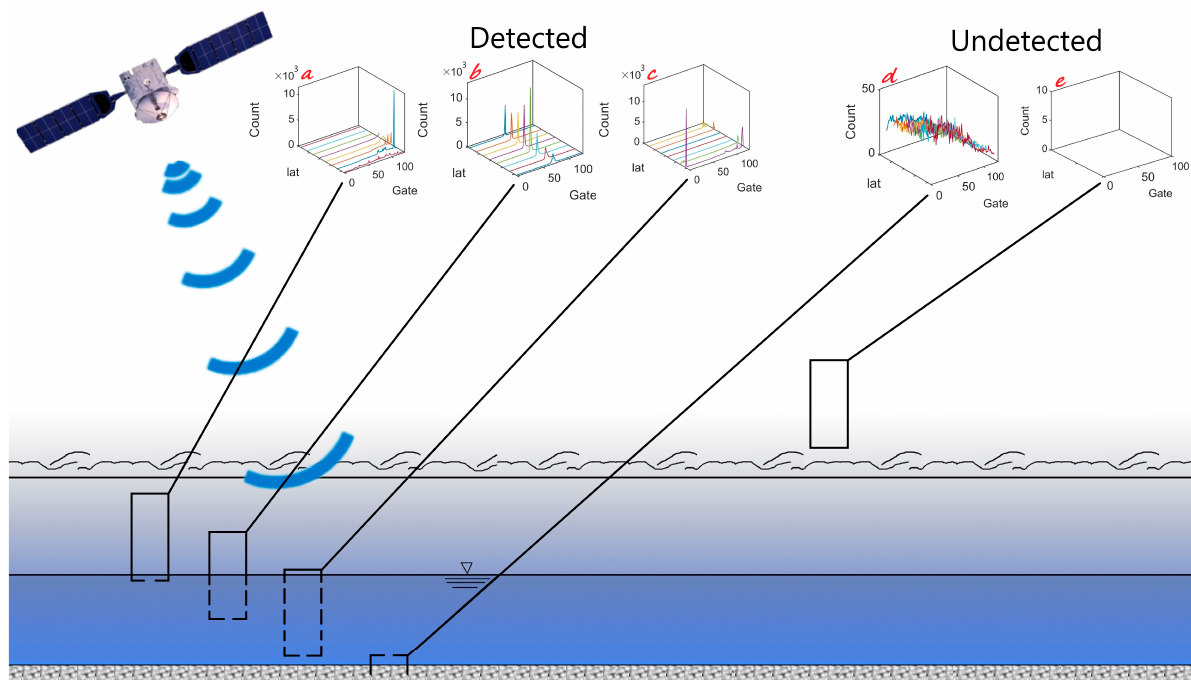
Figure 4. Satellite detection of water surface schematic. The first three ( a – c ) waveform graphs refer to the range window placed on the upper ( a ), in the middle ( b ) and on the lower ( c ) side of the water surface, respectively, and the water surface can be detected. The last two ( d , e ) waveform graphs refer to the range window placed too high ( e ) and too low ( d ), and the water surface cannot be detected. The black rectangles connected to the waveform graphs represent the range window, where the upper part of the water surface is represented by solid line while the lower part is represented by dashed line.